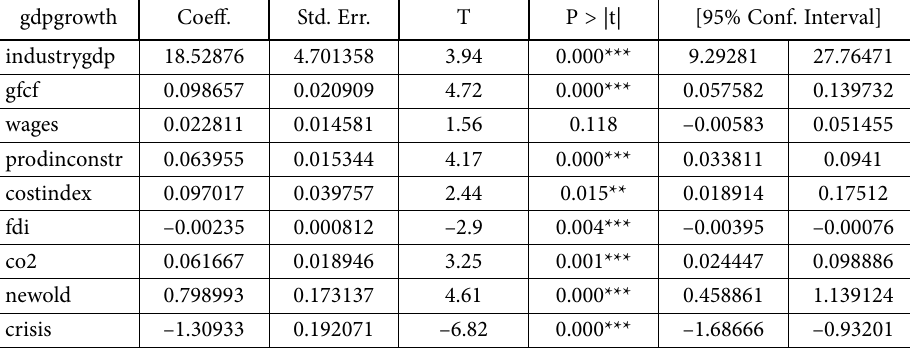
Table 5. Regression results for EU28 (source: Stata, Authors’